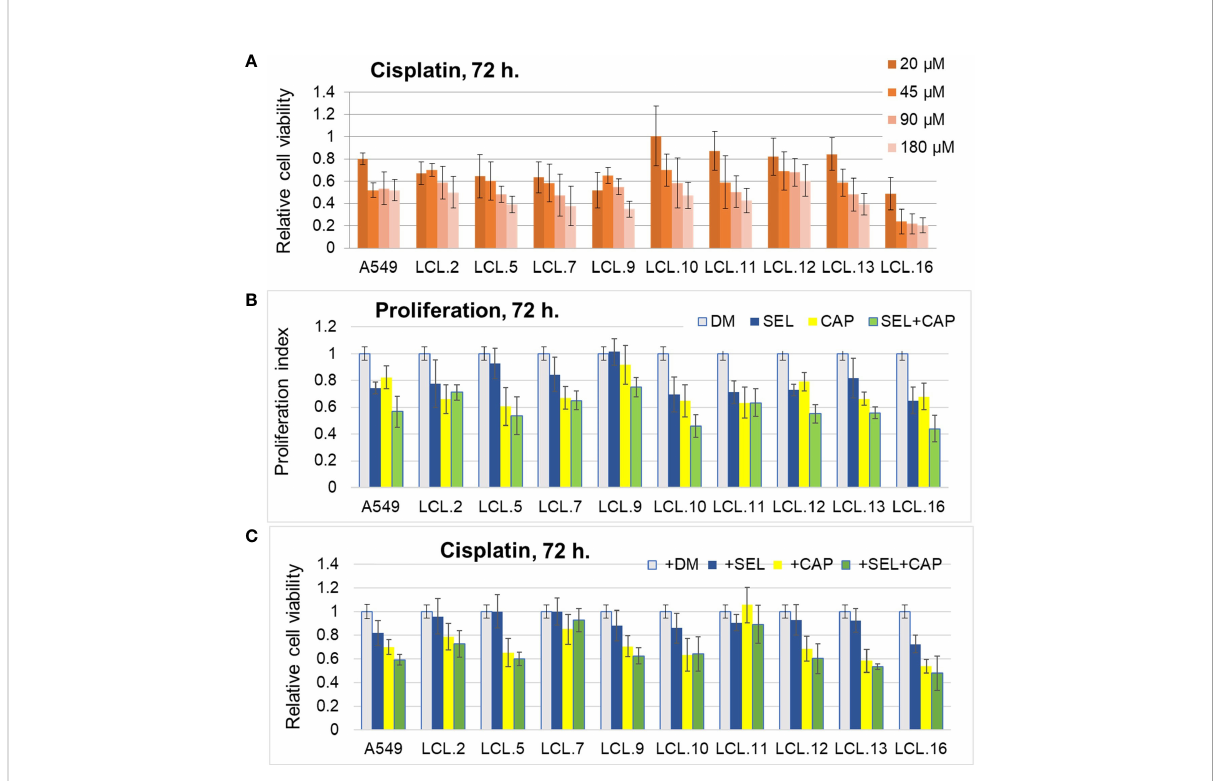
FIGURE 3 Impact of cisplatin and targeted drugs on cell viability of different lung cancer-derived cell lines. (A) Lung cancer-derived cells respond differently to cisplatin. Cell viability was determined by MTT assay and expressed in relation to the viability before the treatment (relative cell viability of initial control =1.0). DM – solvent DMSO. Data are expressed as means ± SD, N = 4. (B) Targeted drugs inhibit cell proliferation. Proliferation without inhibitors is normalized to 1.0. (C) Lung cancer cells respond differently to combinations of targeted drugs and conventional drug cisplatin. Cell survival without inhibitors is normalized to 1.0. Concentrations of cisplatin that induced 50% cell death after 72 h of treatment were used for each cell line. DM – vehicle control (DMSO), SEL – selumetinib (10 µM), CAP – capivasertib (10